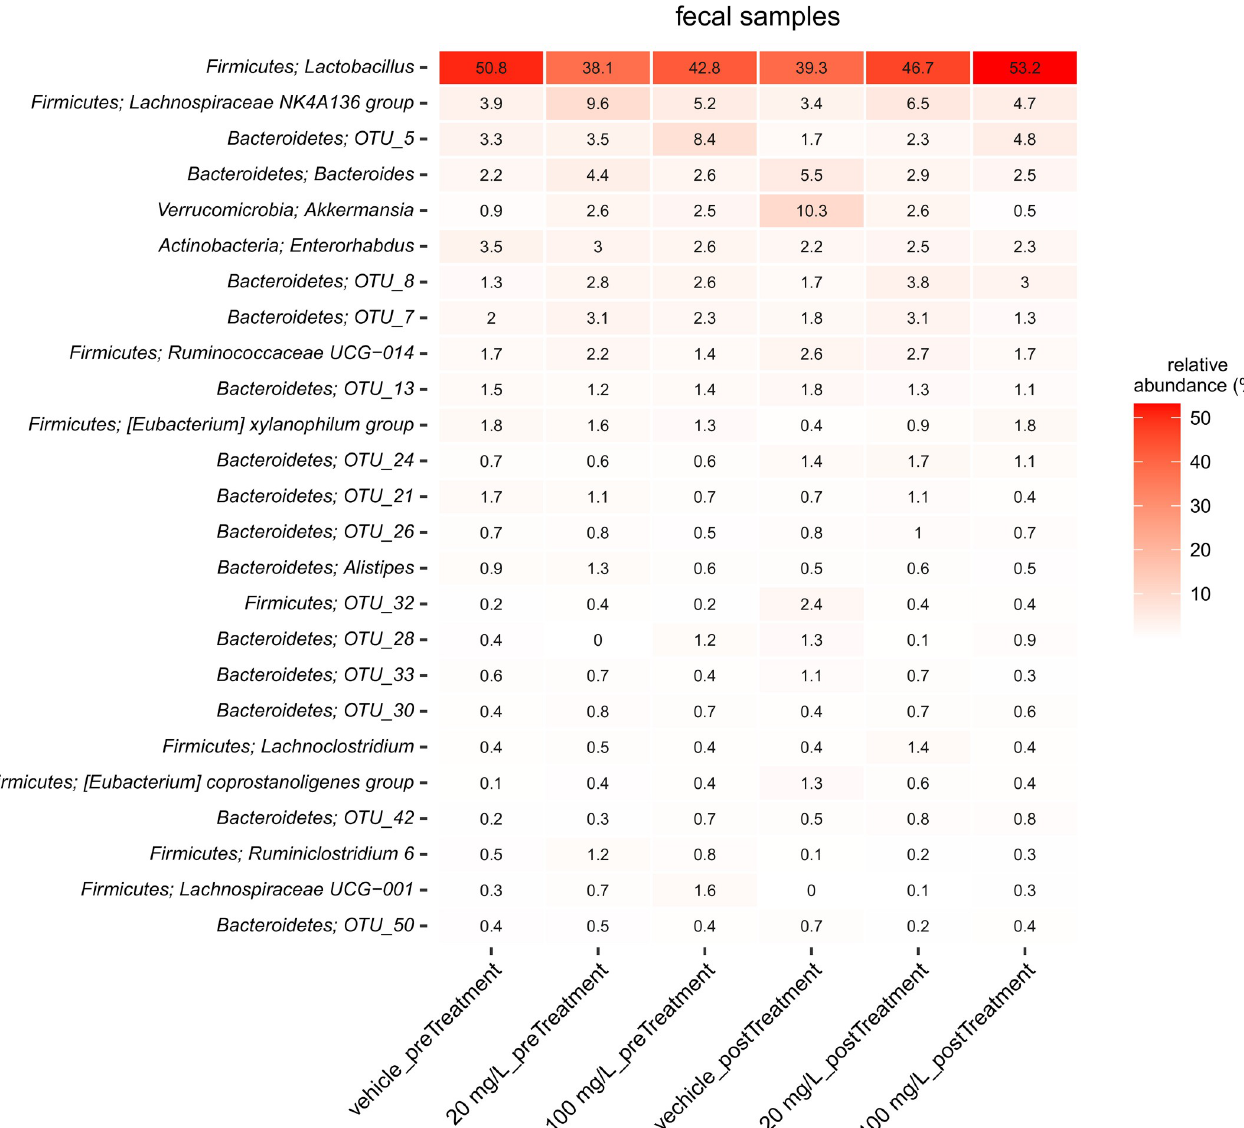
Fig 4. Microbial composition in fecal samples. The figure shows a heatmap of the 25 most abundant genera in fecal samples obtained before treatment was initiated (preTreatment) and the day following four days of treatment (postTreatment). Where available the OTU’s phylum classification is provided along with genus, and if no genus level classification could be obtained, the lowest assigned taxonomic classification is given. Values are shown as normalized fraction of total sequences